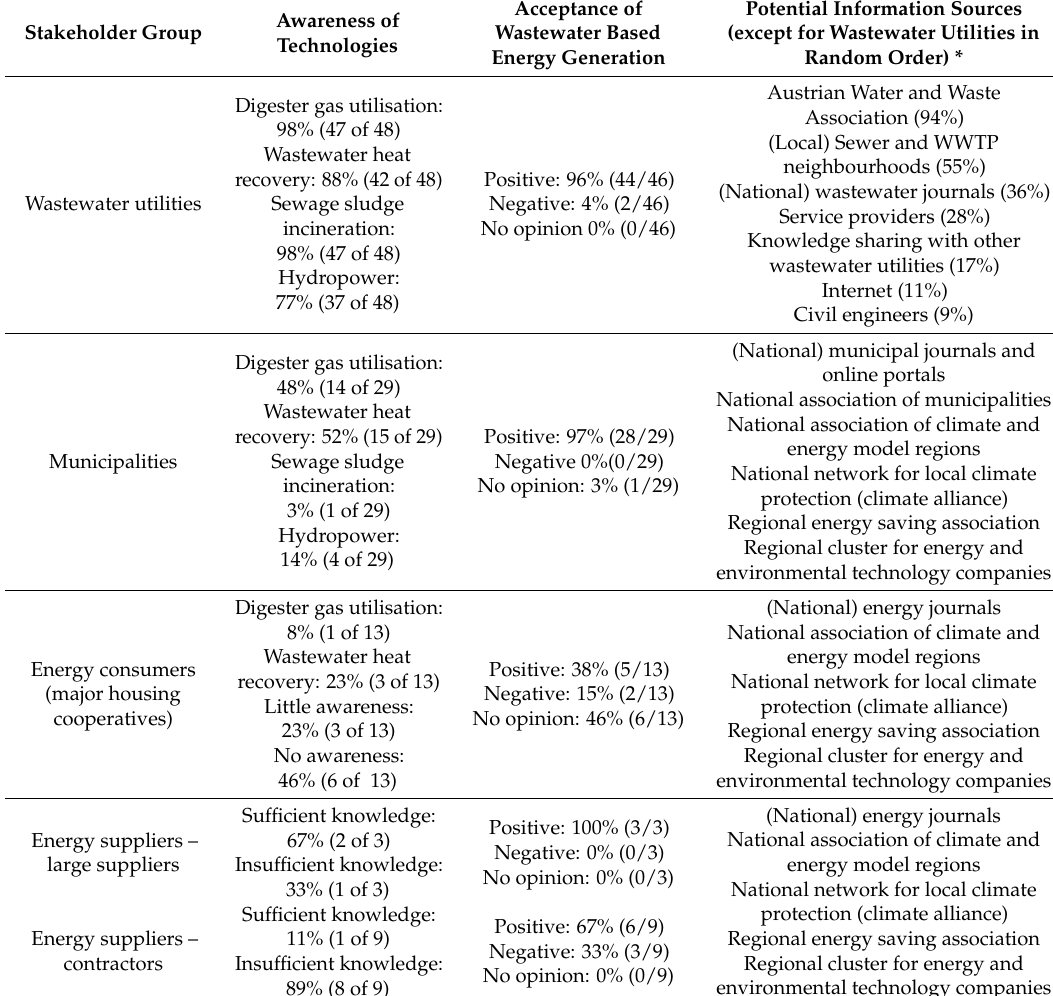
Table 2. Results from interviews with key stakeholder